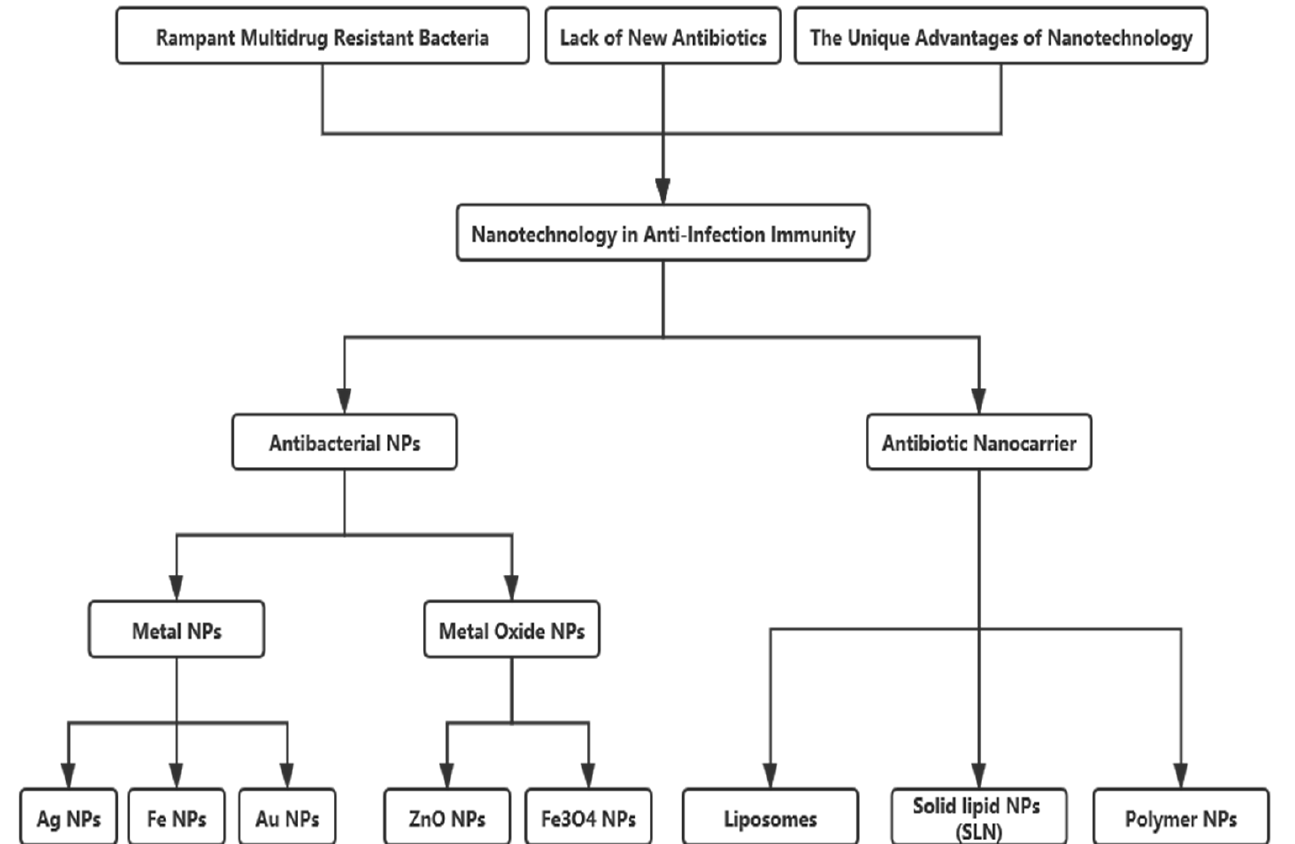
Figure 1. The thought flow chart of the review.